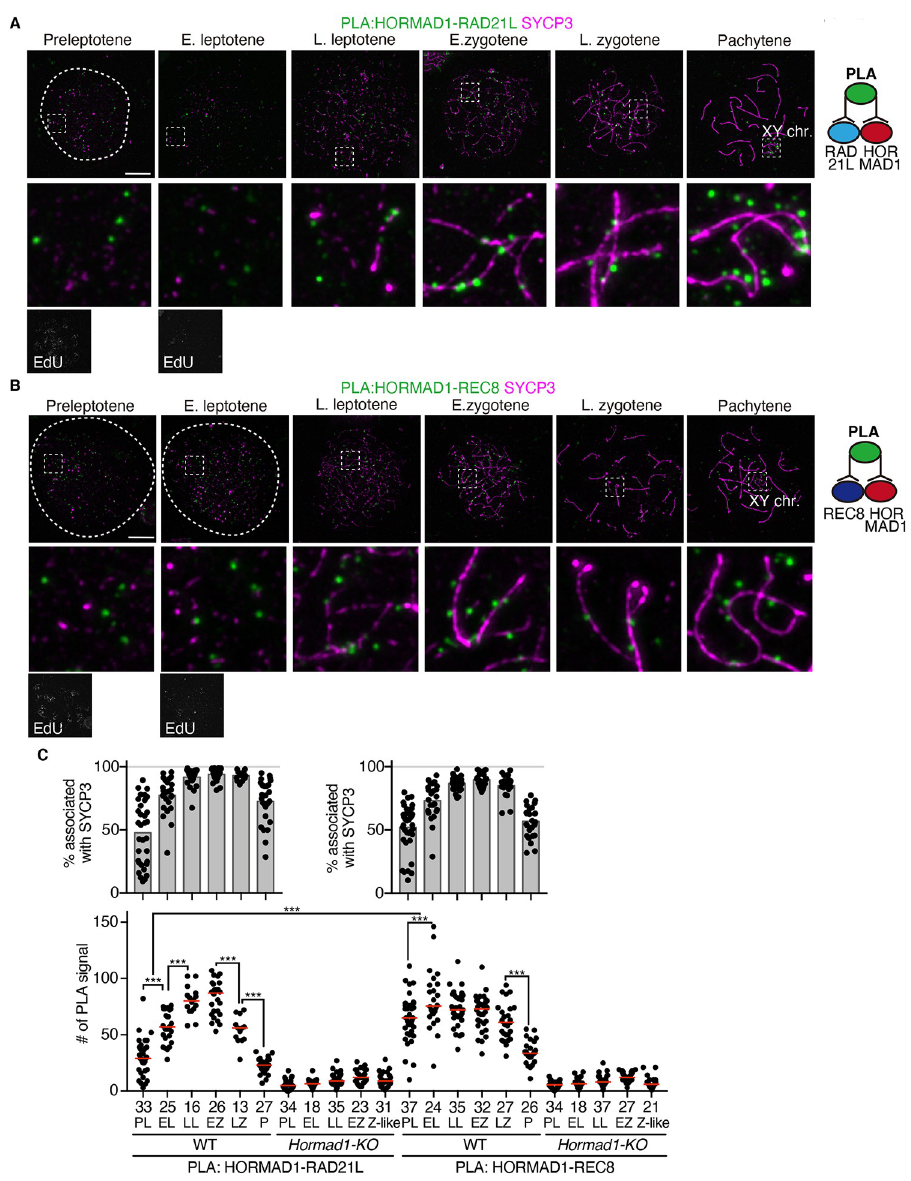
Fig 5. HORMAD1 is in close proximity to meiotic cohesins. (A, B) In situ protein-protein proximity between HORMAD1 and RAD21L (A) or REC8 (B) were analyzed by Proximity Ligation Assay (PLA) shown in green. SYCP3 (magenta) was immunolabelled to analyze the association of PLA signals with the axis. (C) Scatter plot shows the number of PLA signals per nucleus at different stages during meiotic prophase I (Lower). Hormad1 -KO cells were used as a negative control to assess the specificity of the PLA signals. Quantification of PLA signals that were associated with SYCP3 is shown on the upper graph. Bar graphs indicate average % of PLA signals associated with SYCP3 threads (upper). N: the number of the cells observed. Statistical significance was assessed by one-way ANOVA followed by Turkey’s multiple comparisons test with a single pooled variance. ��� : P < 0.001. Scale bars:10 μ